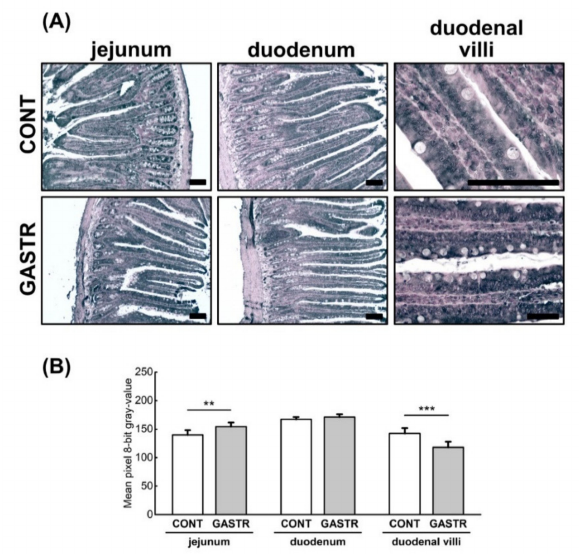
Figure 7. ( A ) Representative photomicrographs of the immunohistochemical reactions for occludin. Sections developed in 3,3 (cid:48) -diaminobenzidine tetrahydrochloride with metal enhancer; counterstain- ing performed with Nuclear Fast Red. All the scale bars represent 100 µ m. ( B ) The intensity of expression of occludin measured by the comparison of the pixel brightness values in the microscopic images converted to 8-bit grayscale. The higher the pixel value, the lower the intensity of immunore- actions. Graph shows mean ± standard error. Significance was established using a two-tailed Student’s t -test (normally distributed data), Welch’s test (normally distributed data with unequal variances) or the Mann–Whitney test (for pairwise comparisons with at least one non-normally distributed dataset); ** p < 0.01; *** p < 0.001.